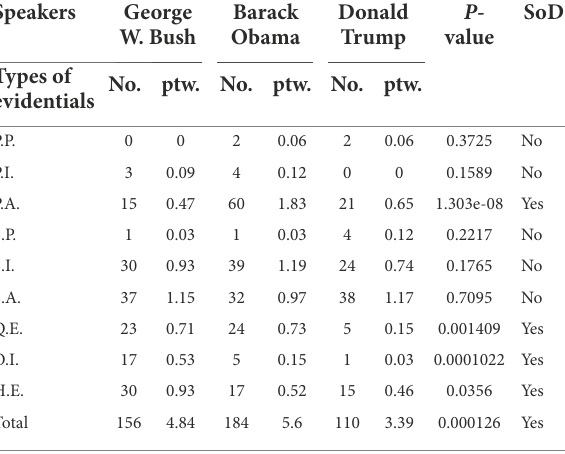
TABLE 4 A comparison of types of evidentials in three cases.